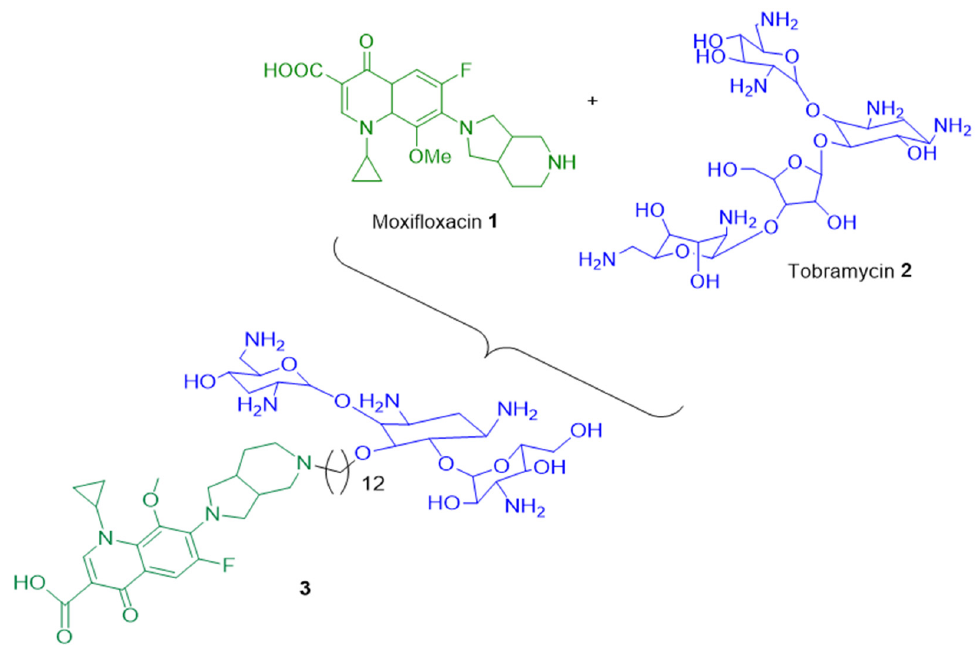
Figure 2 . Drug combination 3 of moxifloxacin with tobramycin. Figure 2. Drug combination 3 of moxifloxacin with